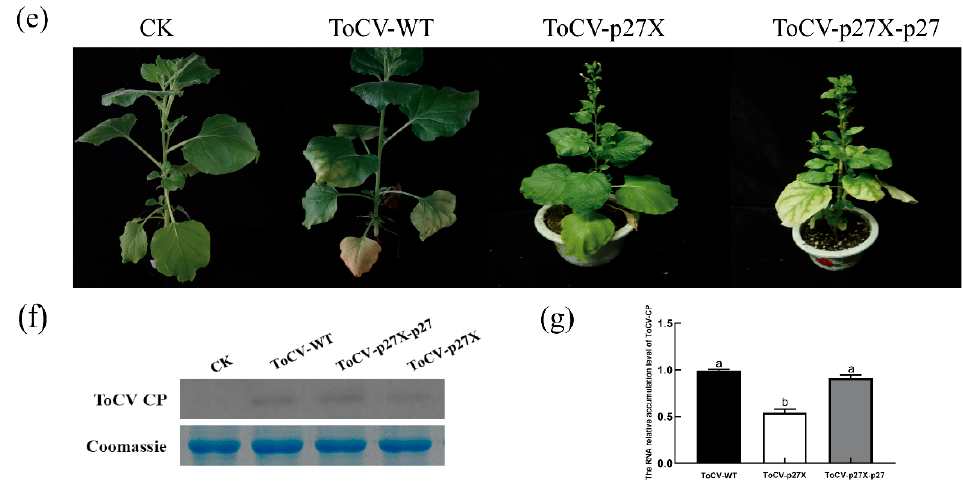
Figure 1. P27 promotes ToCV systemic infection in N. benthamiana plants. ( a ) Schematic diagram of the structure of the ToCV p27 base mutation. ( b ) Diagram of results of the sequencing of the p27 termination. ( c ) Schematic diagram of the genomic structure of ToCV-WT and ToCV-p27X. ( d ) Schematic map of the genomic structure of N. benthamiana infected with the ToCV-p27X system. ( e ) Four weeks after inoculation, WT, mutant, and anaplerosis ToCV caused symptoms in N. benthamiana . ( f ) Four weeks after ToCV immunosuppression, the expression of the ToCV CP protein in the leaves of the N. benthamiana system was detected by Western blot analysis. ( g ) Four weeks after inoculation, the accumulation of ToCV CP in N. benthamiana was detected by qRT-PCR.